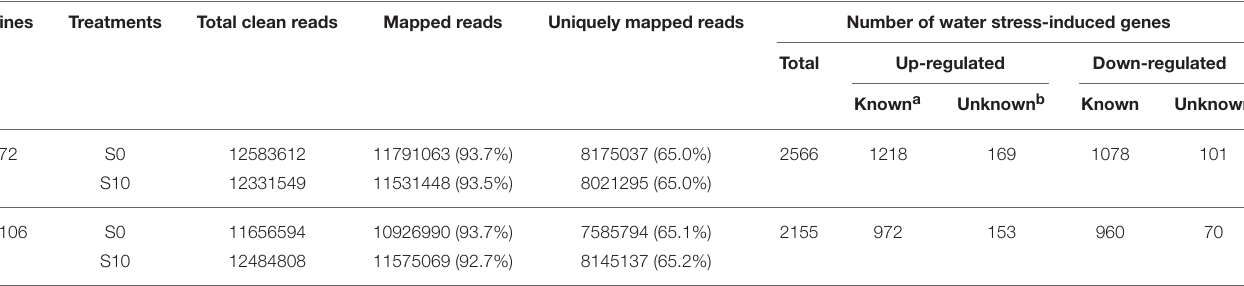
TABLE 4 | Differentially-expressed genes (DEGs) between seedlings under control (S0) and water stress (S10) conditions.